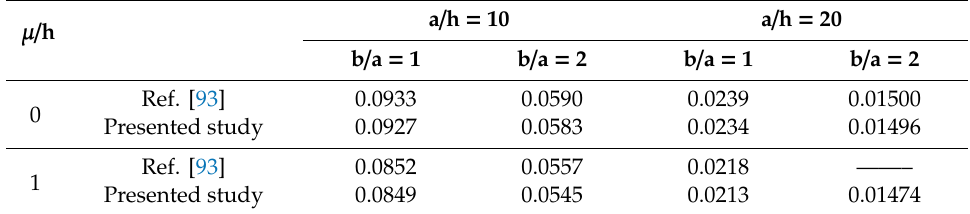
Table 4. Comparison of dimensionless frequencies ( ω h (a = 10, E = 30 × 10 6 , υ = 0.3, ρ = 1, l = 0 and R1 = R1 = ∞